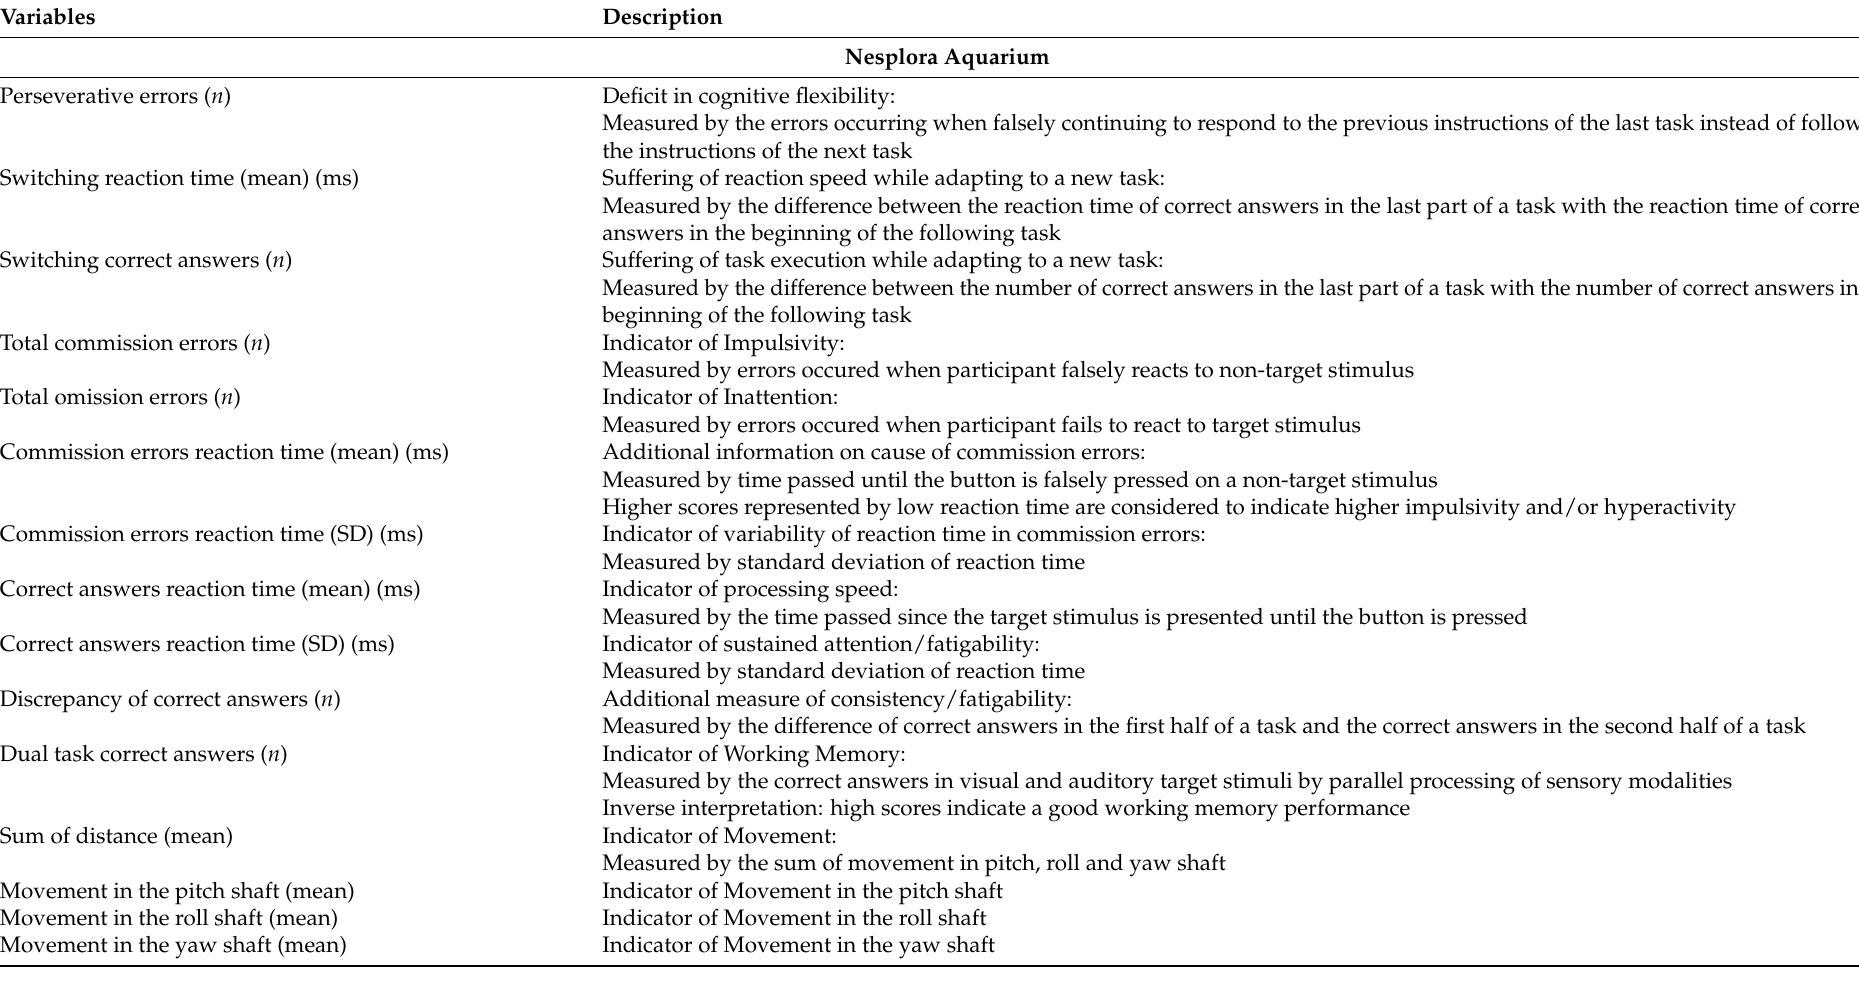
Table A1. Description of Variables of Nesplora Aquarium and